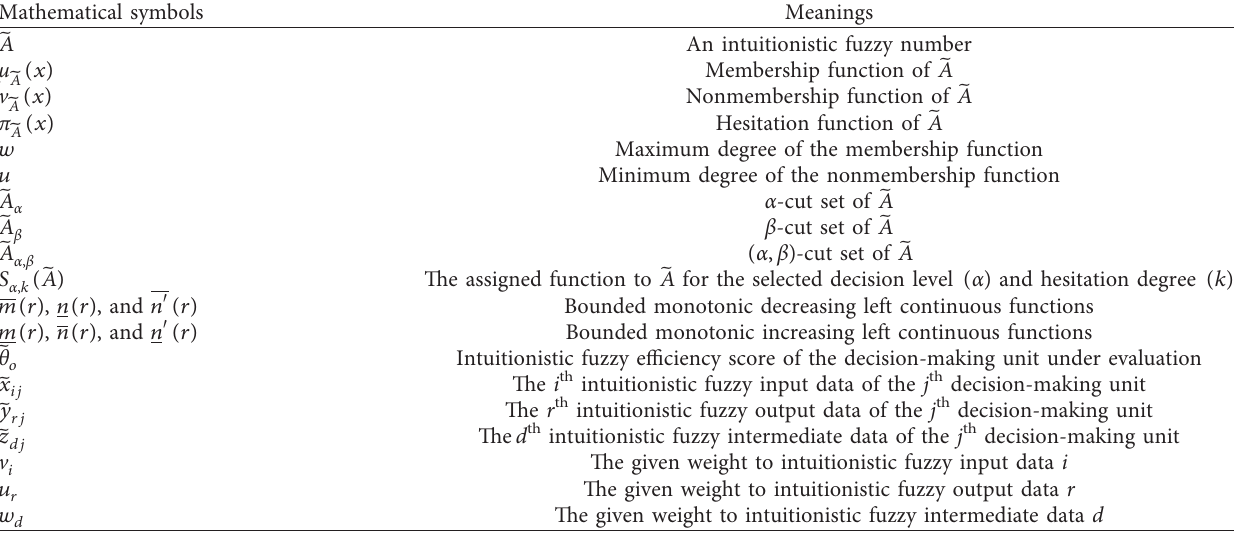
Table 2: Mathematical symbols utilized in the following